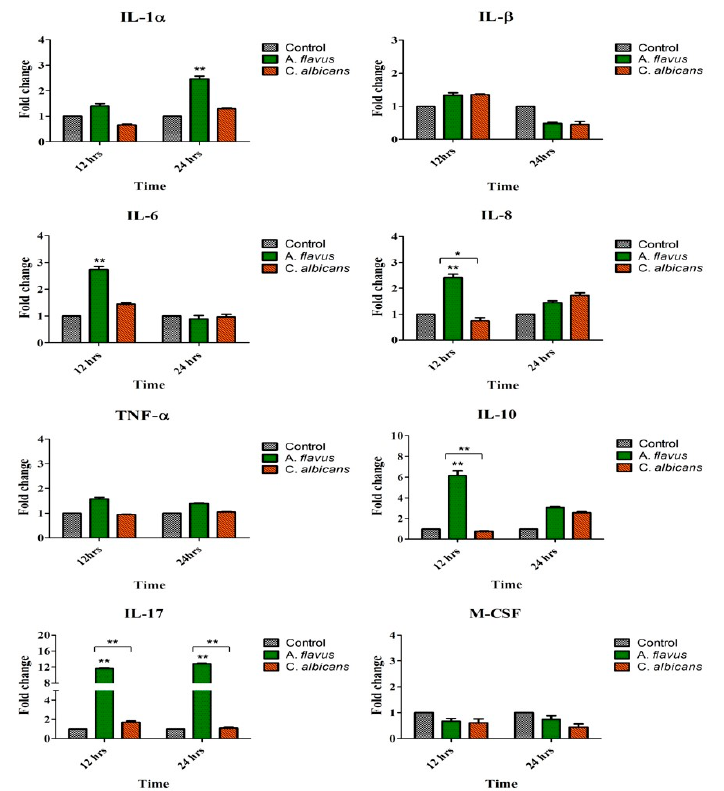
Figure 2. CHME-3 cells were challenged with A. flavus and C. albicans at indicated time points. Postinfection human microglial total RNA was subjected to RT-PCR and qRT-PCR using SYBR green assay with cytokine-specific primes. Representative RT-PCRs of each cytokines were shown. Human microglia with no fungal infection cDNA was used as control. β -actin was used as an endogenous control. Data are from n = 3 independent experiments done in triplicate. * p <